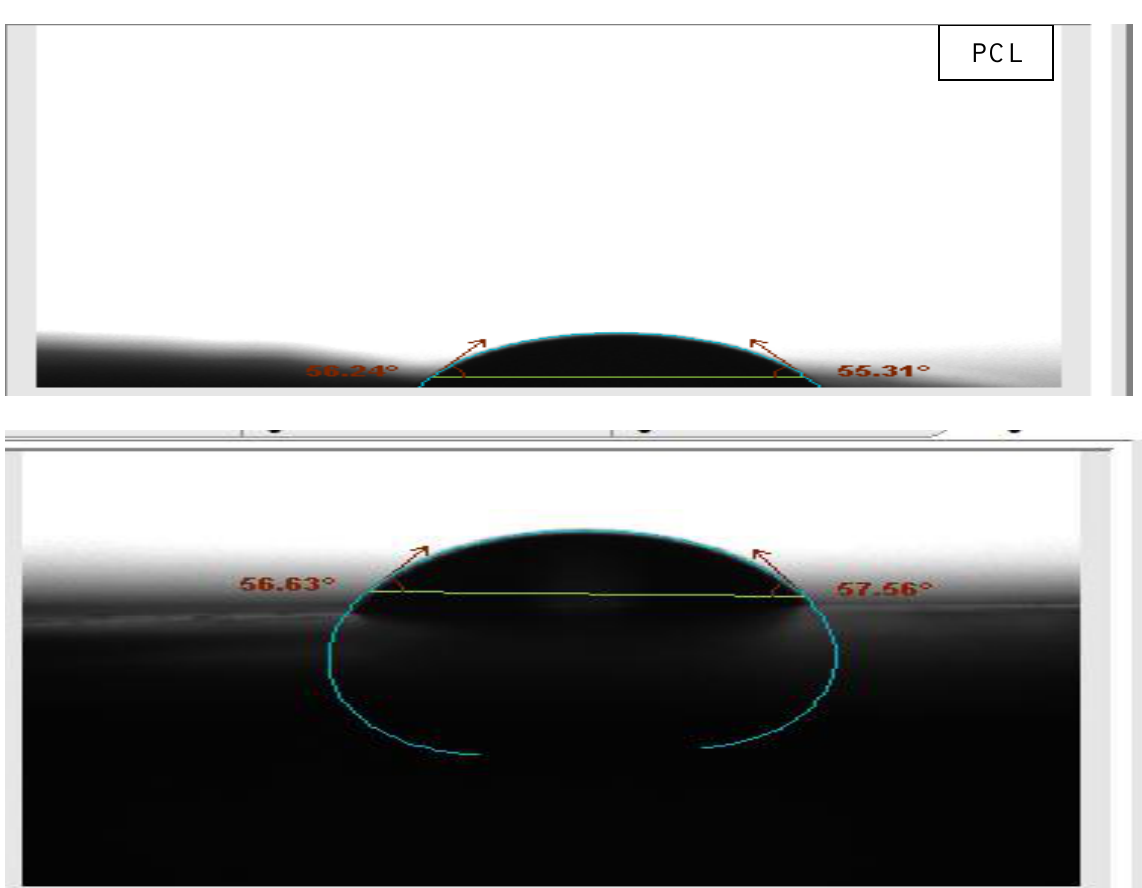
Fig.4: Contact angle test of pure PCL and PCL /ZnO nanocompositesat different concentration.